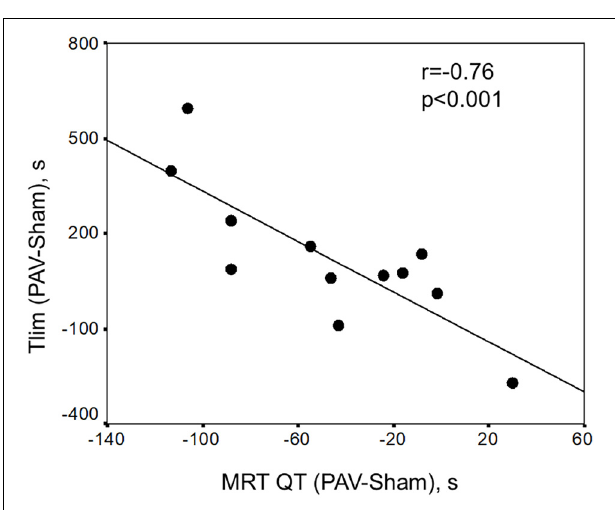
FIGURE 3 | Significant inverse relationship between the difference of limit of tolerance with PAV-Sham vs. the difference of mean response time (MRT) of QT (PAV-Sham). These data suggest that the higher variation of Tlim with PAV, the faster lower “central” cardiovascular kinetics (Pearson correlation = 0.76, p <